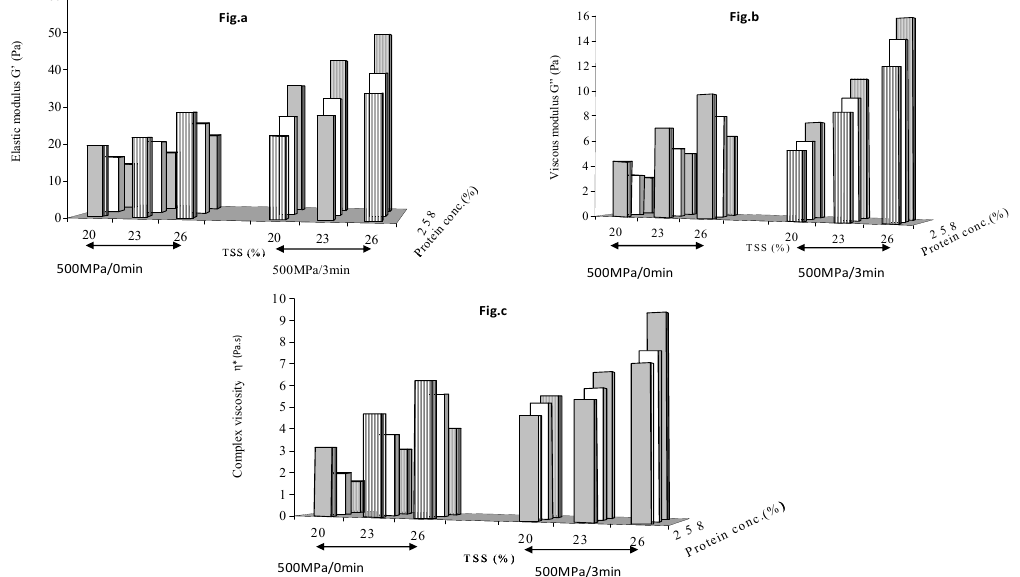
Figure 5. Elastic modulus as influenced by protein concentration and ( a ) pressure ( b ) holding time.